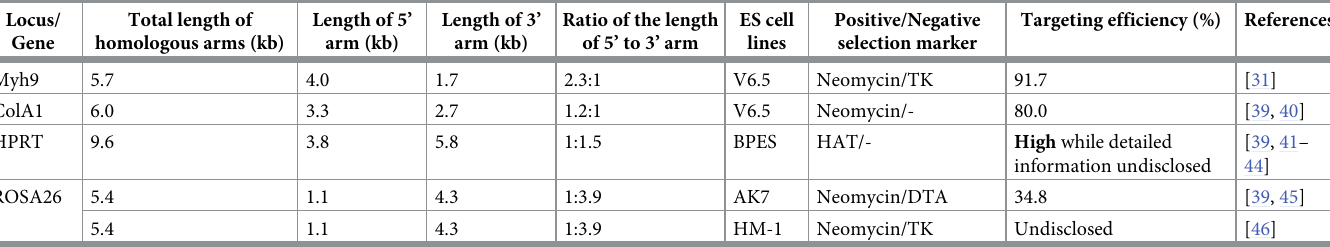
Table 1. Comparison of the HR efficiency and features of frequently targeted loci/sites. Locus/ Total length of Length of 5’ Gene homologous arms (kb) arm (kb)